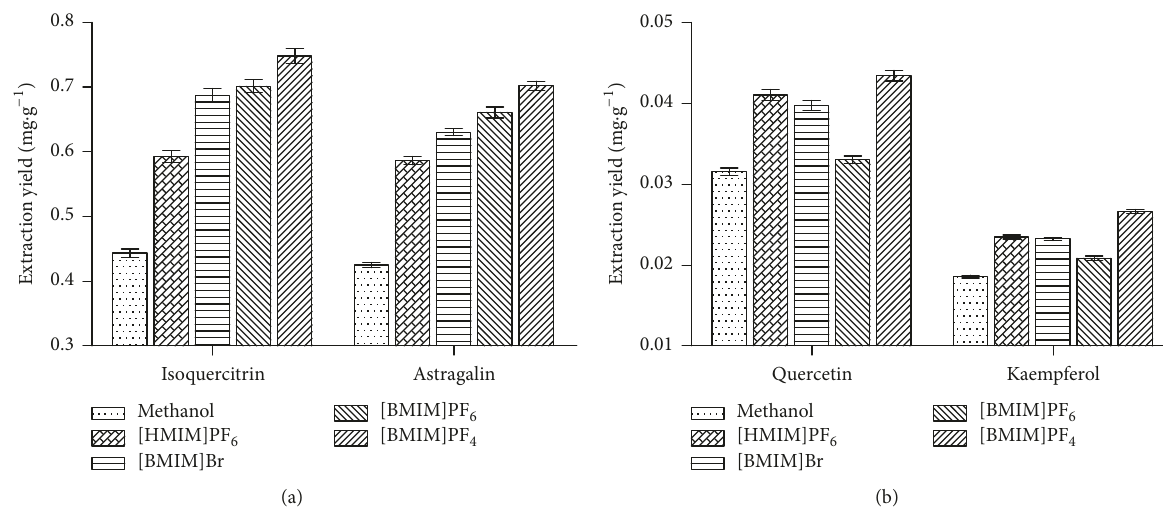
Figure 3: Effect of type of ILs on extraction yields. Concentration of the four ILs in methanol solution: 0.5 mol ⋅ L −1 ; the particle size: 50 mesh; solid-liquid ratio: 1: 10g ⋅ mL −1 ; ultrasound time: 30min; ultrasound power: 500 W; centrifugation speed: 5000 r ⋅ min −1 .